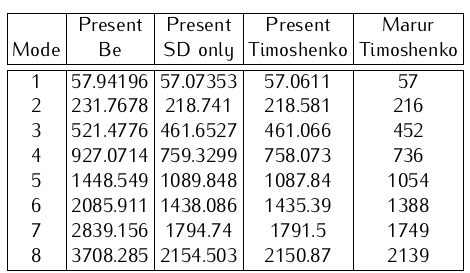
Table 1. Natural frequencies of sandwich beam obtained using the Bernoulli-Euler beam theory (Equation 23), including the effect of shear deformation (Equation 22), using the Tim- oshenko beam theory and comparison with the results of Marur and Kant